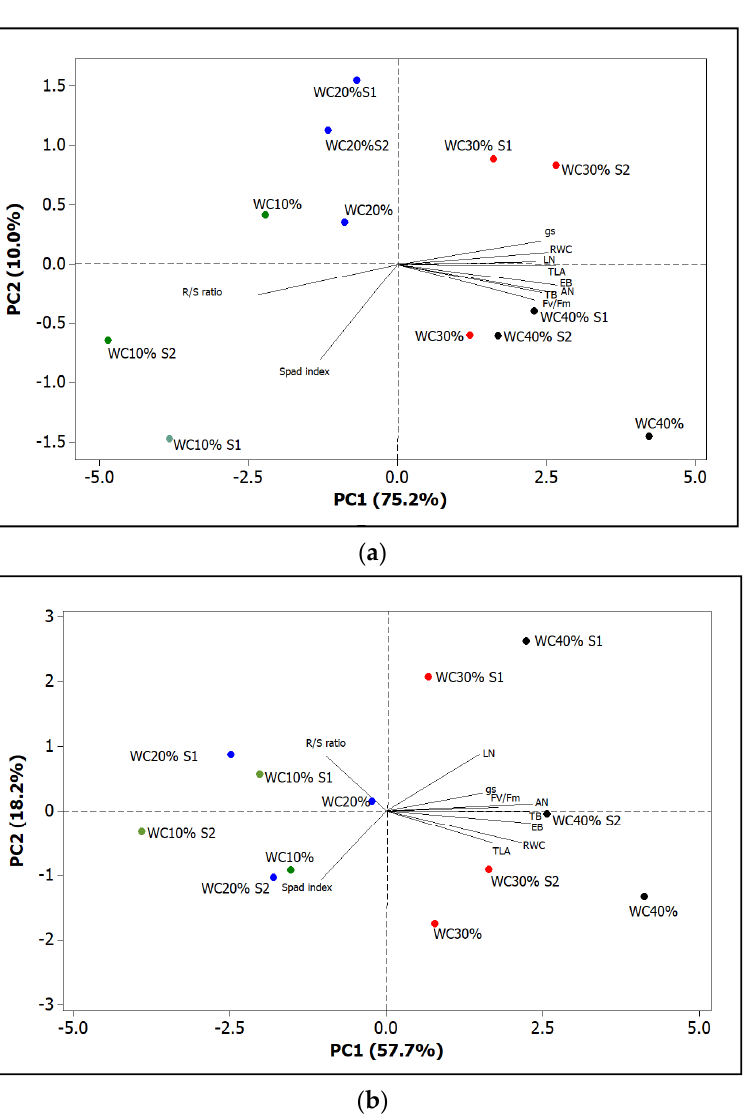
Figure 9. Principal component loading plot and scores of PCA epigeous and total dry biomass, R/S ratio, total leaf area, leaf number, Spad index, gas exchange, chlorophyll a fluorescence, and RWC for Callistemon ( a ) and Viburnum ( b ) as drought and saline aerosol stress treatments. TB = total dry biomass; EB = epigeous dry biomass; R/S = root to shoot ratio; TLA = total leaf area; LN = leaf number.